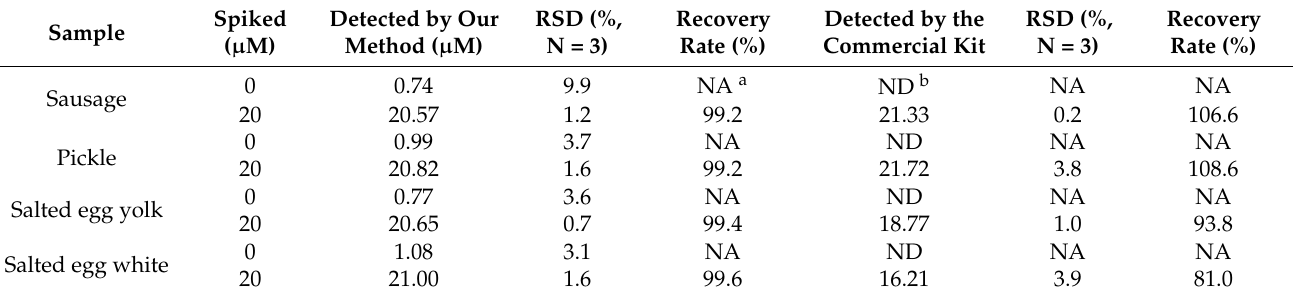
Table 1. Results of our ratiometric colorimetric method in detecting nitrite in food samples.